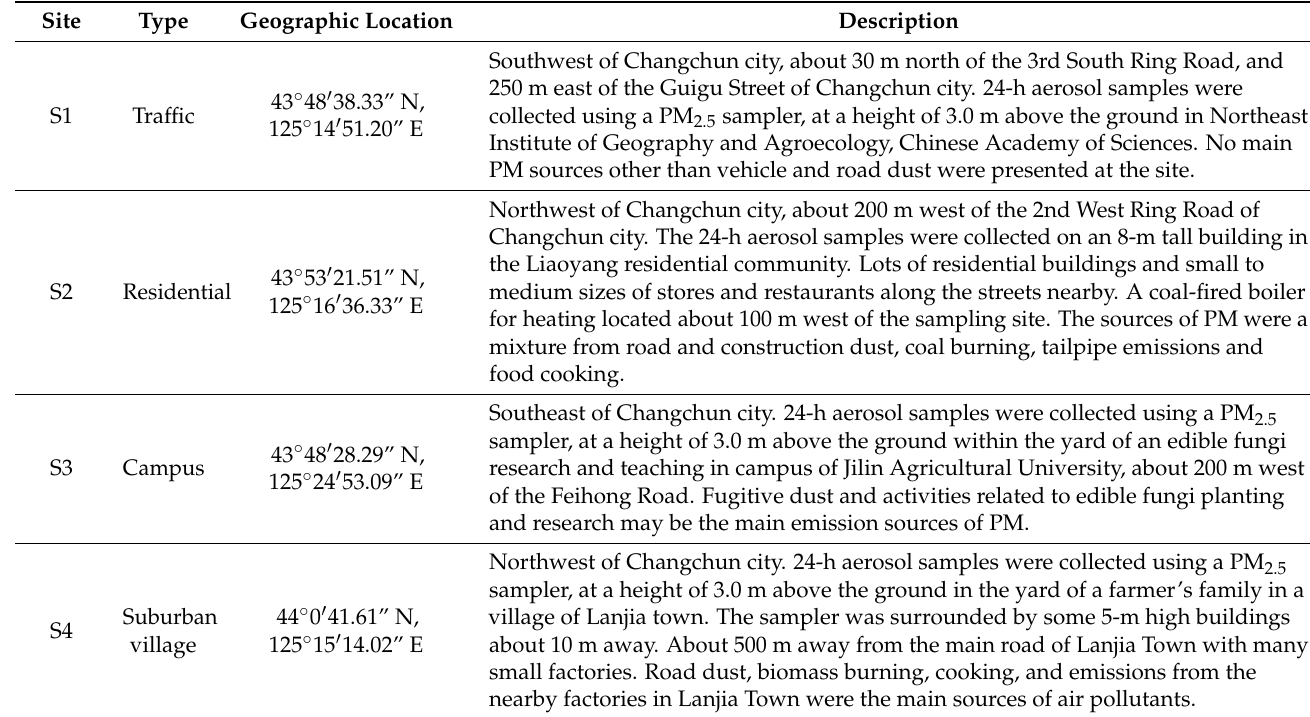
Table 1. Description of the sampling sites in this